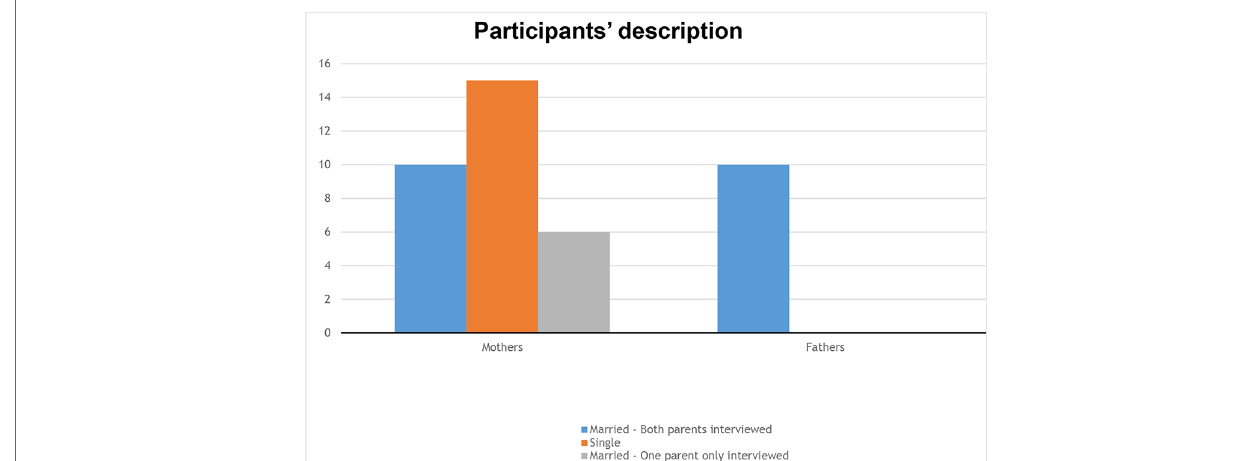
FIgURE 1 | Particpant’s